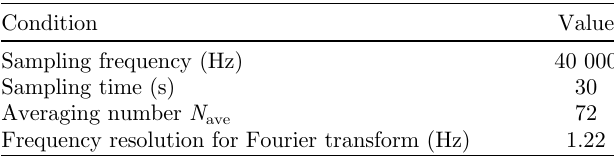
Table 2. Measurement conditions for radiated sound. Table 3. Measurement conditions for